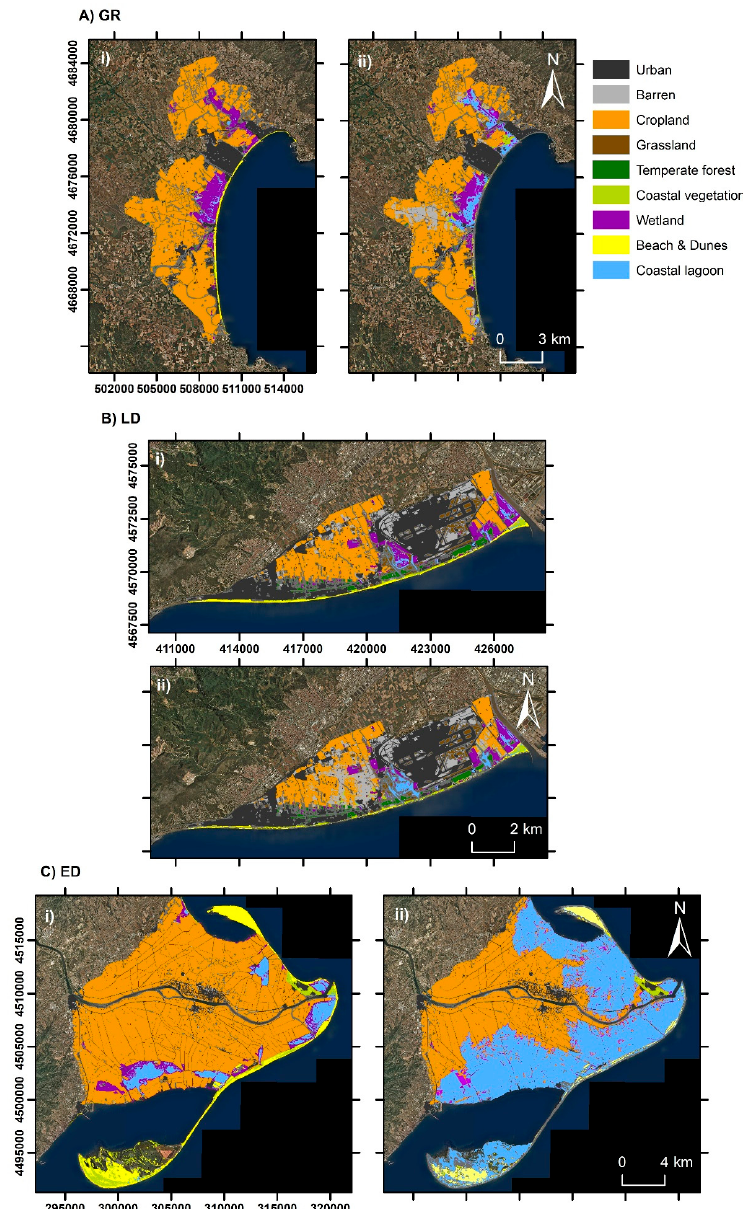
Figure 9. Habitat distribution under (i) current conditions and (ii) projected changes assuming habitat conversion by 2100 under RCP8.5 scenario at the ( A ) GR, ( B ) LD, ( C ) ED. (The geographic coordinate system is ETRS89/UTM zone 31N).